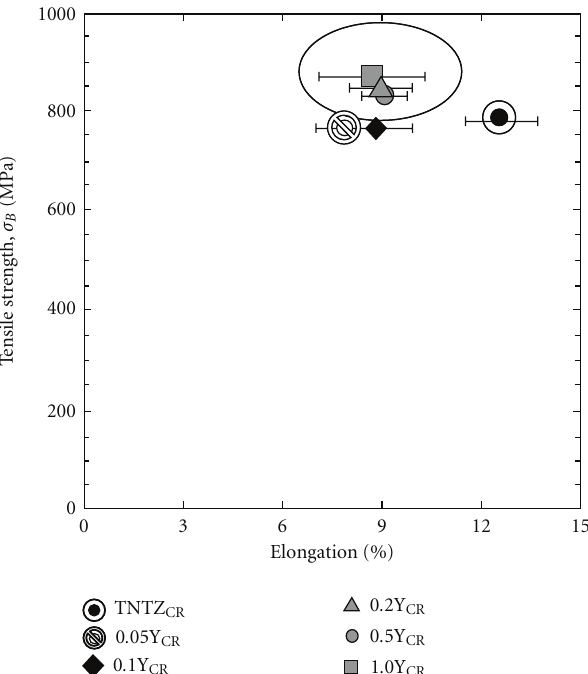
Figure 10: Relationship between tensile strength and elongation of TNTZ added with Y 2 O 3 (0.05Y CR : TNTZ-0.05Y CR , 0.1Y CR : TNTZ- 0.1Y CR , 0.2Y CR : TNTZ-0.2Y CR , 0.5Y CR : TNTZ-0.5Y CR , and 1.0Y CR : TNTZ-1.0Y CR ) and TNTZ subjected to severe cold rolling after solution treatment (TNTZ CR ).